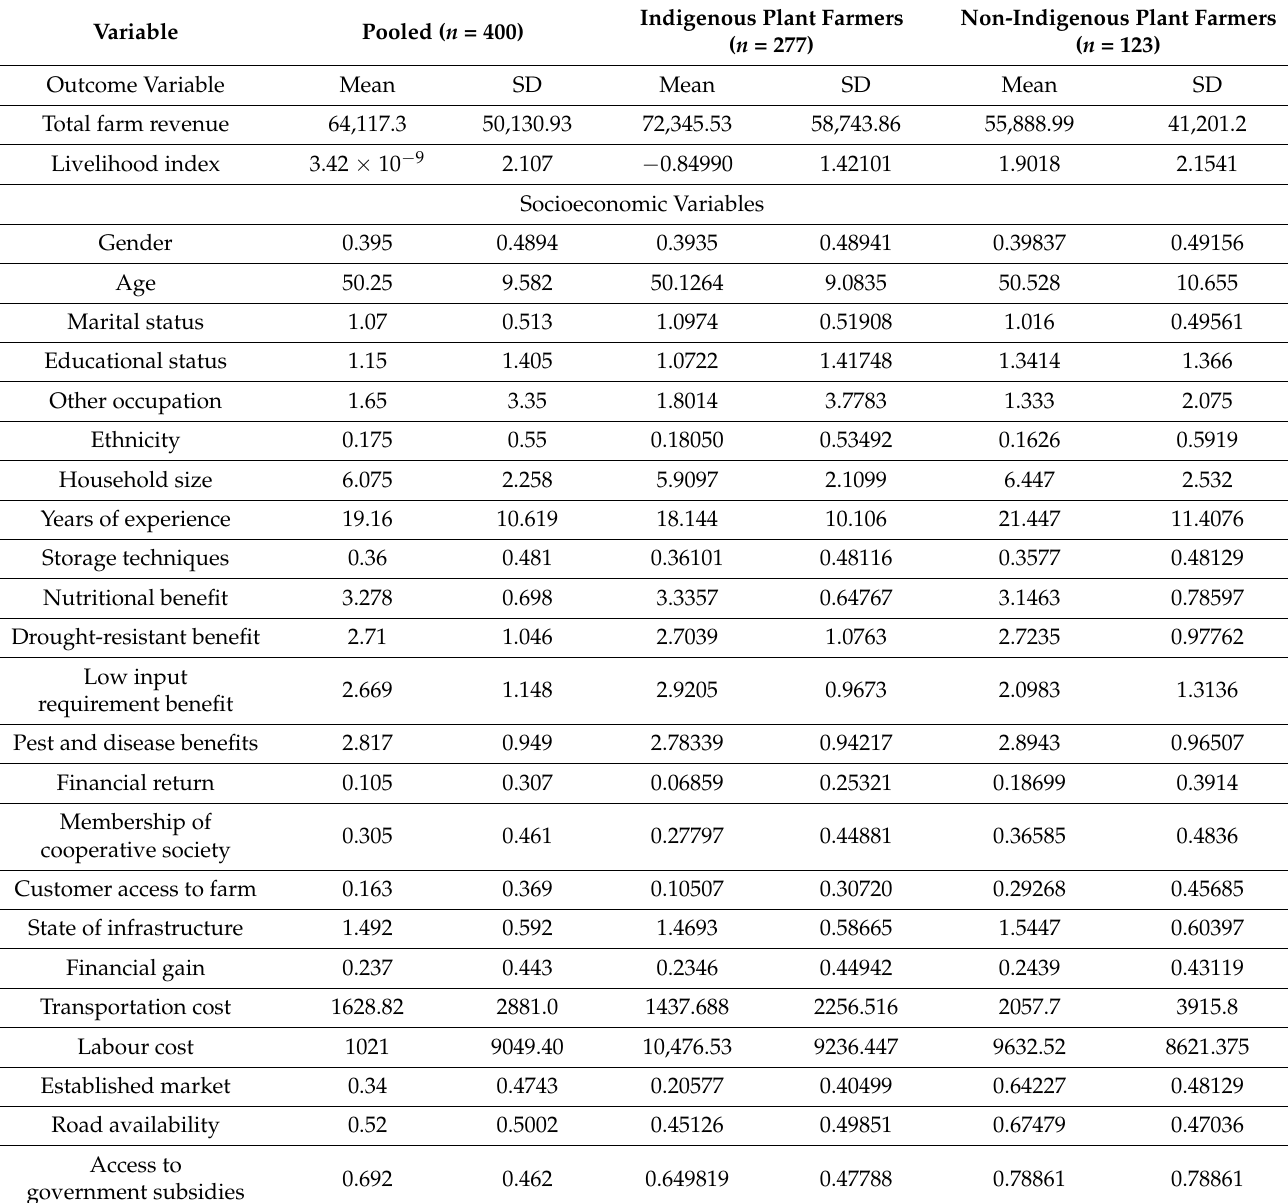
Table 4. Socioeconomic characteristics disaggregated by land utilization status of participants from the selected areas of Ondo State, Nigeria. SD = standard